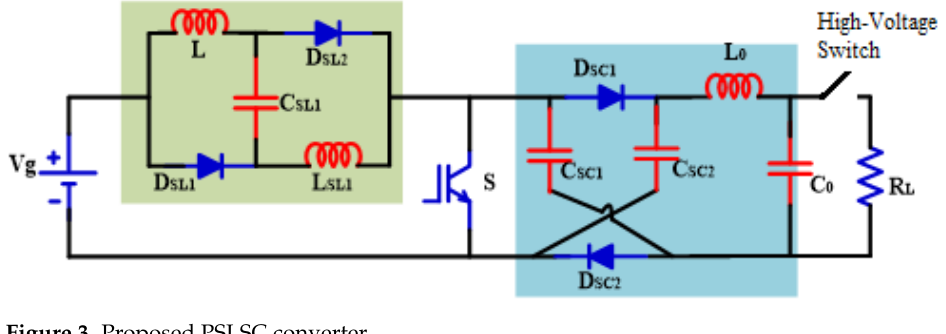
Figure 3. Proposed PSLSC converter.